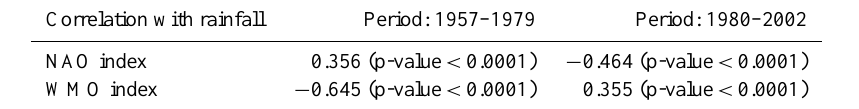
Table 3. Correlation between the 3-yr moving average series of rainfall in Ebro River Basin with NAO and WeMO indexes for two different periods.